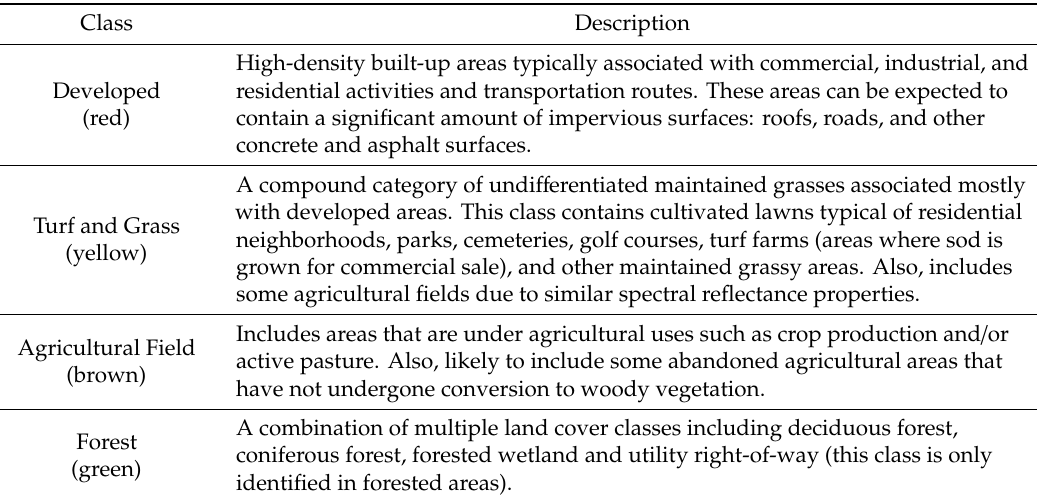
Table 1. Descriptions of four major land cover categories in Connecticut’s Changing Landscape (CCL)